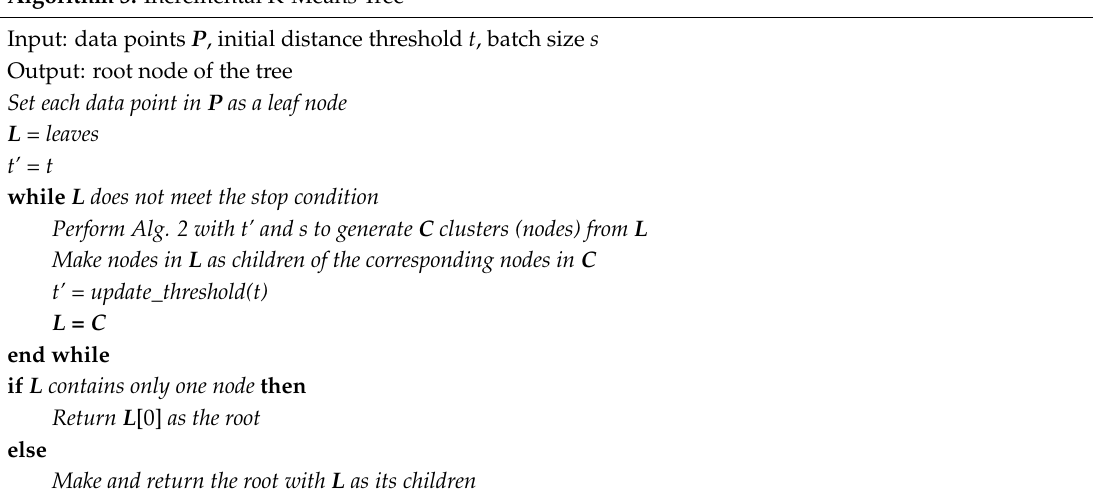
Algorithm 3: Incremental K-Means